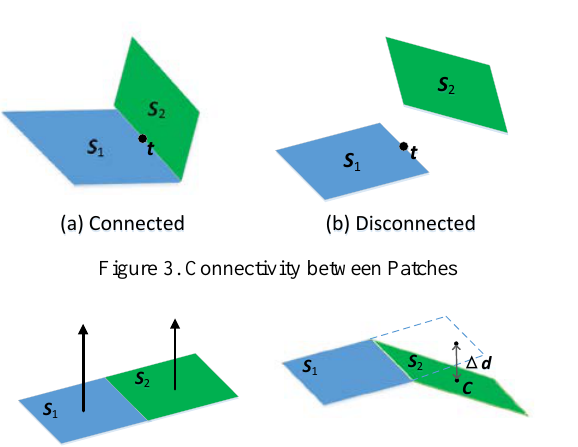
Figure 3. Connectivity between Patches